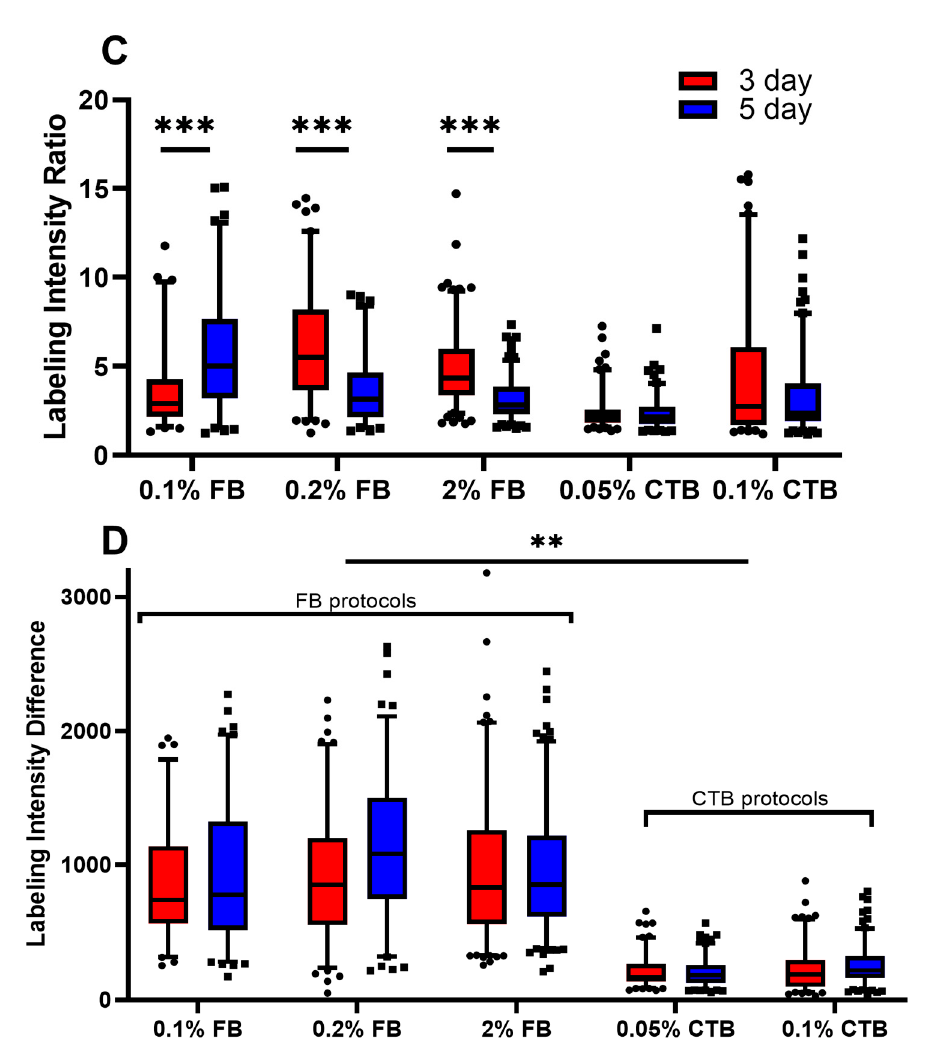
Figure 1. Neuronal labeling intensity ratio and difference among tracer protocols of young mice (6–7 weeks). ( A ) An FB (2%, 5-day labeling intensity protocol) image taken from the tissue of a young mouse. ( B ) A CTB (0.1%, 5-day labeling intensity protocol) image taken from the tissue of a young mouse. ( C ) Intensity ratios (labeling/background intensity). The number of cells analyzed per group (from left to right in order) is 75, 83, 102, 87, 145, 155, 30, 30, 30, and 30. ( D ) Intensity difference for all experimental groups measured 4 days after fixation. The number of cells analyzed per group (from left to right in order) is 72, 83, 102, 87, 145, 155, 30, 30, 30, and 30. Data are median ± 95% confidence interval. The circles and rectangles are data points outside the 95% confidence interval for the 3-day and 5-day protocols, respectively. *** denotes p < 0.001, ** denotes p <